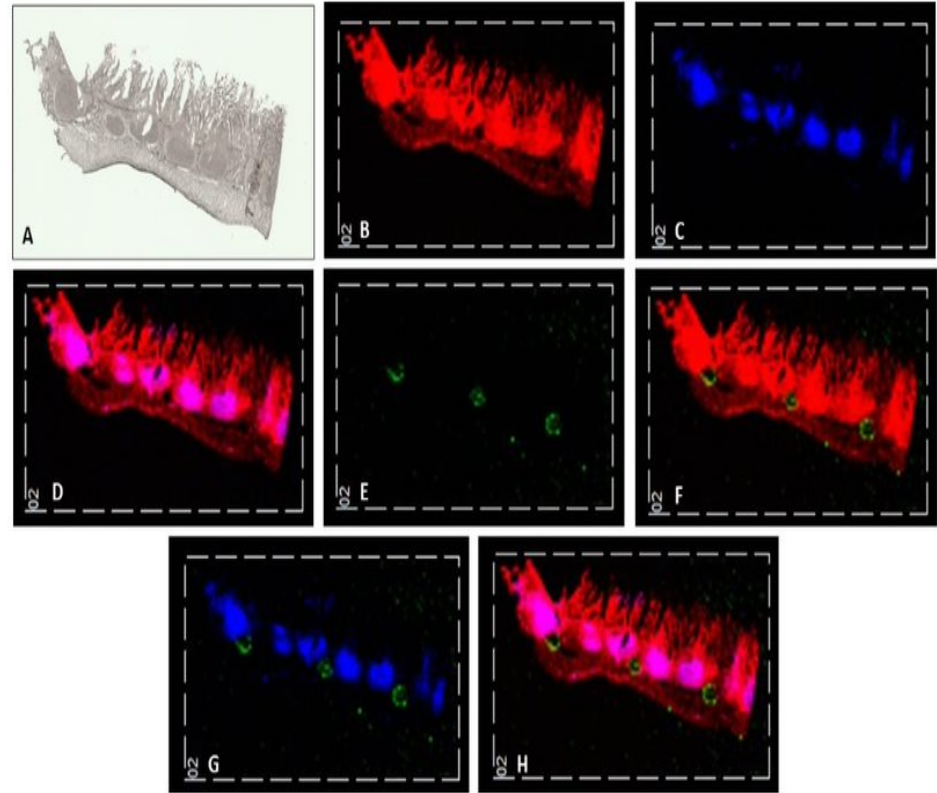
Figure 2. Using the QV600 LLI, intact porcine small intestinal tissue was treated with 0.5 mg/mL Atorvastatin over a 6 h period to investigate drug absorption. ( A ) A scanned image of the intestinal tissue section taken using a Super Coolscan 5000 ED Film Scanner with the apical layer facing upwards. ( B ) A MALDI-MS image showing cholesterol [Chol+H-H 2 O] + at m/z 369 in red. ( C ) A MALDI-MS image showing the Peyer’s patches at m/z 389 in blue. ( D ) A MALDI-MS image showing cholesterol [Chol+H-H 2 O] + at m/z 369 in red and Peyer’s patches in blue; overlapping ions are shown in pink. ( E ) A MALDI-MS image showing the sodium adduct of atorvastatin at m/z 581 in green. ( F ) A MALDI-MS image showing the sodium adduct of atorvastatin at m/z 581 in green and cholesterol [Chol+H-H 2 O] + at m/z 369 in red. ( G ) A MALDI-MS image showing sodium adduct of atorvastatin ( m/z 581) in green and Peyer’s patches ( m/z 389) in blue. ( H ) A MALDI-MS image showing the sodium adduct of atorvastatin at m/z 581 in green, cholesterol [Chol+H-H 2 O] + at m/z 369 in red and Peyer’s patches in blue; overlapping ions are shown in pink.